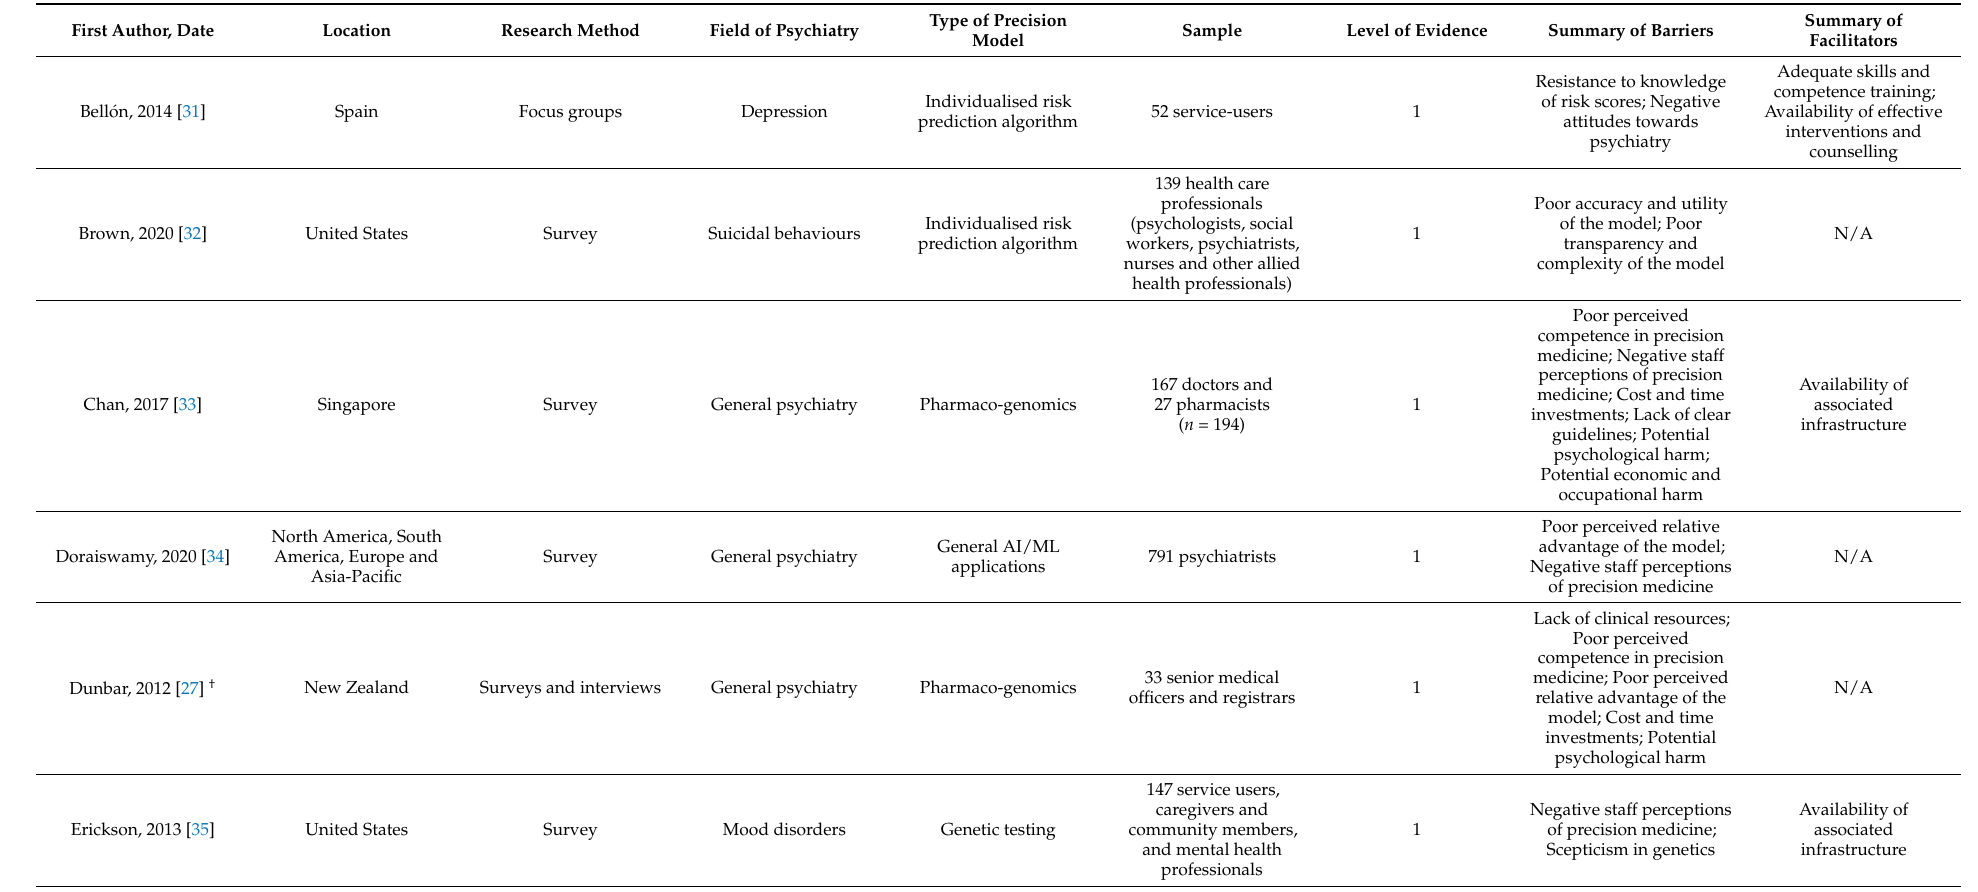
Table 2. Characteristics of the included